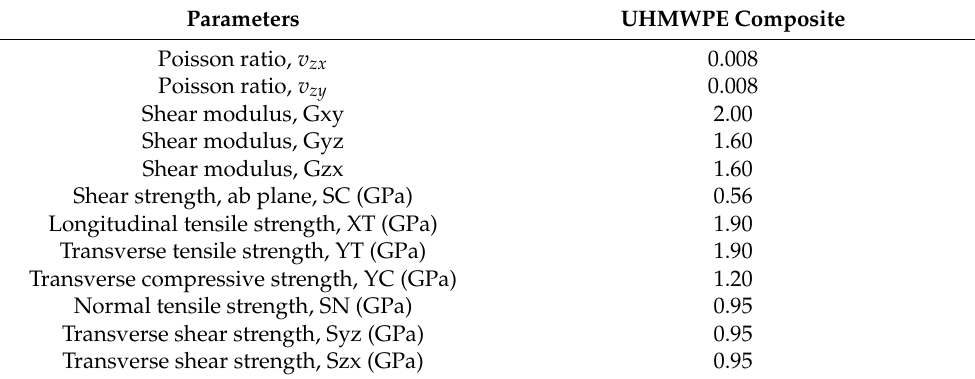
Figure 4. The deformation features of the UHMWPE laminate impacted various projectile nose shape. ( a – e ) were 60°, ogival, 120°, flat, and hemispherical nose shape projectile, respectively. 3.2. Numerical Results 3.2.1. The SEA Ability In the ballistic tests, the residual velocity of the projectile was measured by the high- speed camera. Table 5 shows the residual velocity of the projectiles in experiments and simulations. The maximum relative error was 11.7%, indicating that the numerical results had a good agreement with the experimental results. For comparison purposes, the initial velocity of the projectile in simulations was set as 600 m/s. Previous studies discovered that the energy efficiency of shear failure model was lower than that of the tensile failure